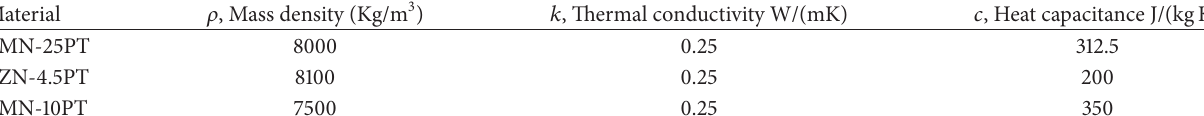
Table 1: Physical properties of the electrocaloric elements [16–19].